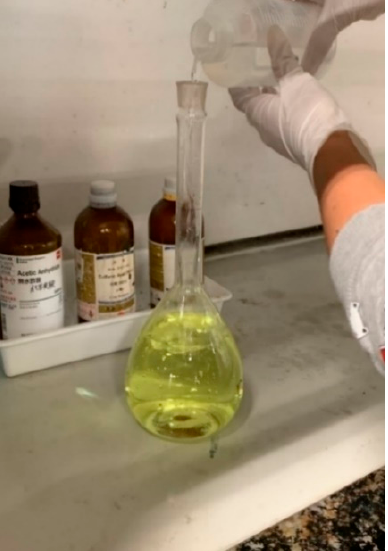
Figure 6. Preparation of a liter of Drabkin’s solution in a volumetric flask.